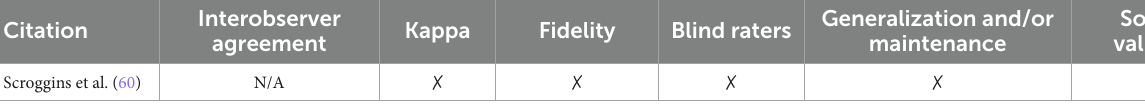
TABLE 5 Secondary quality indicators of single-subject research.